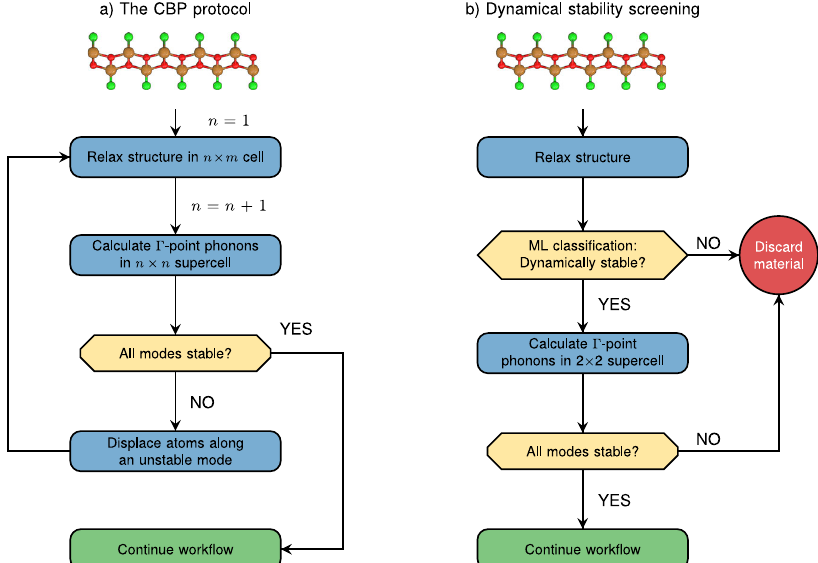
Fig. 1 Work fl ow diagram. Work fl ow to test for dynamical stability of (two-dimensional) crystals in high-throughput computational studies. In the fi rst step, a machine learning classi fi cation algorithm is used to fi lter out unstable crystals at a minimal computational cost. The stability of the remaining crystals is assessed using the CBP protocol. Only materials predicted to be stable by the CBP protocol continue to the characterization work fl